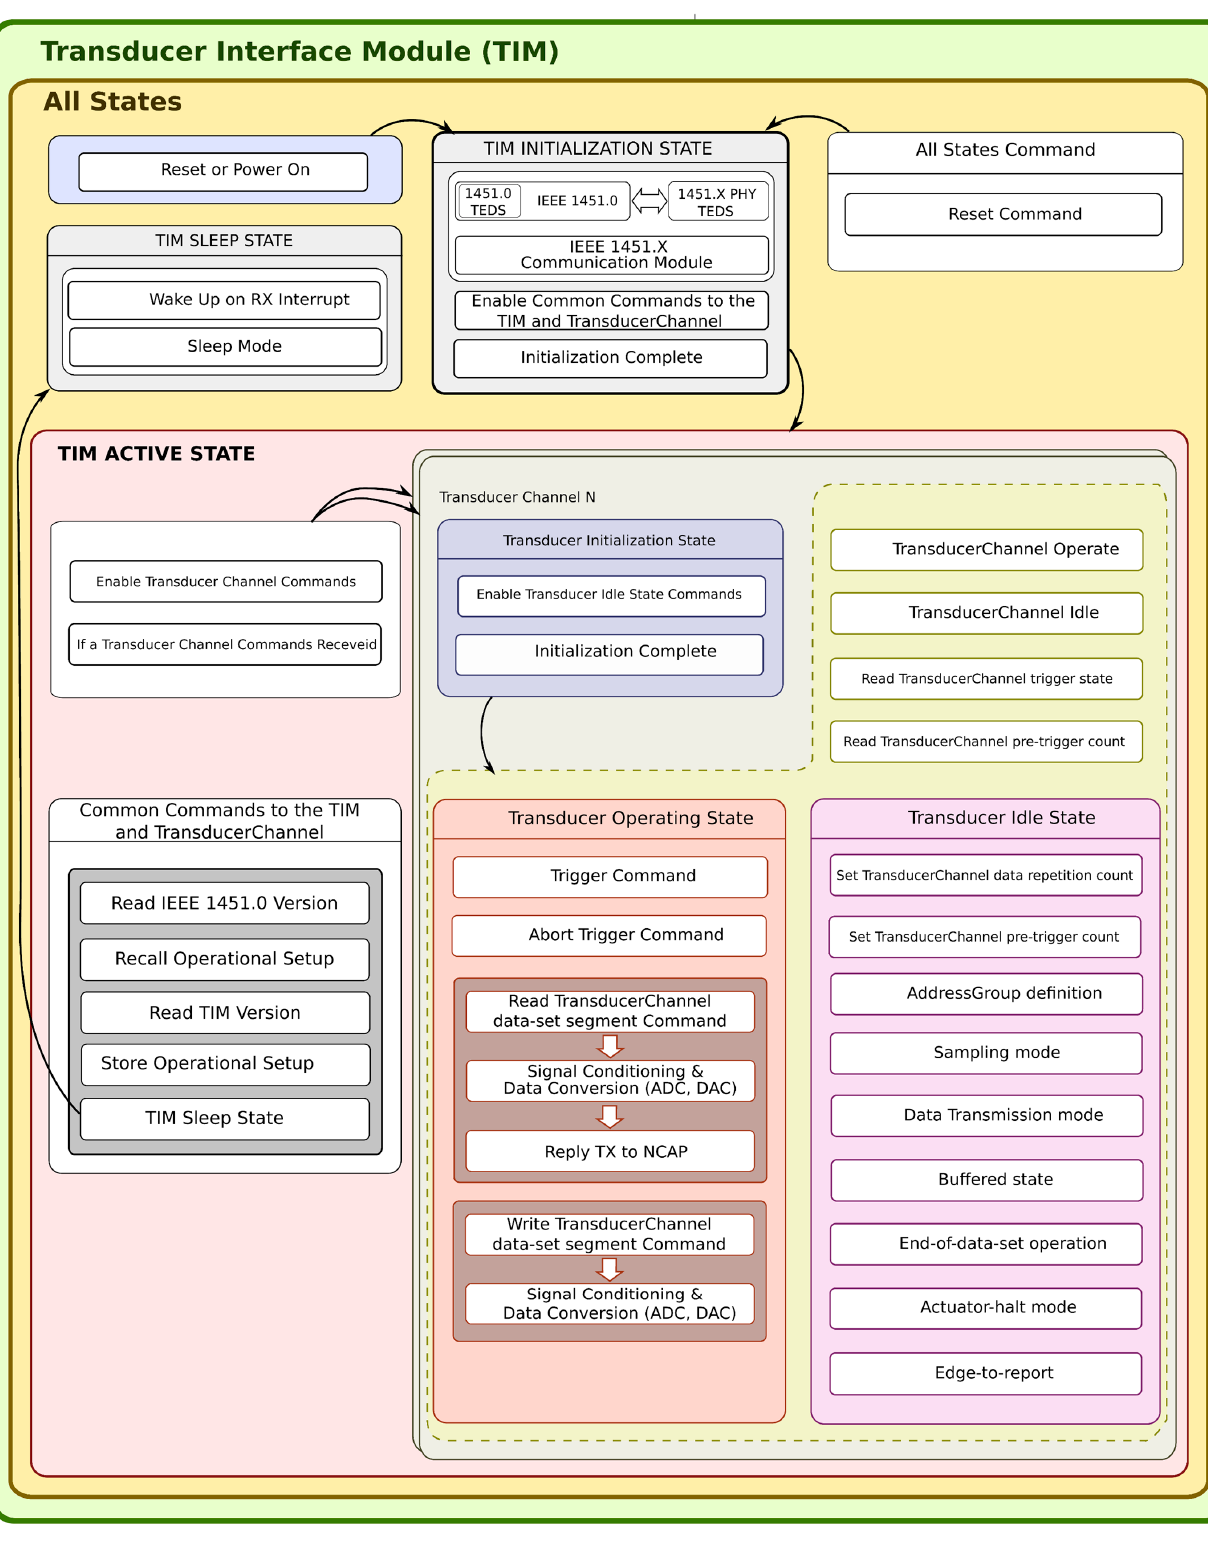
Figure 4. The state machine inside a